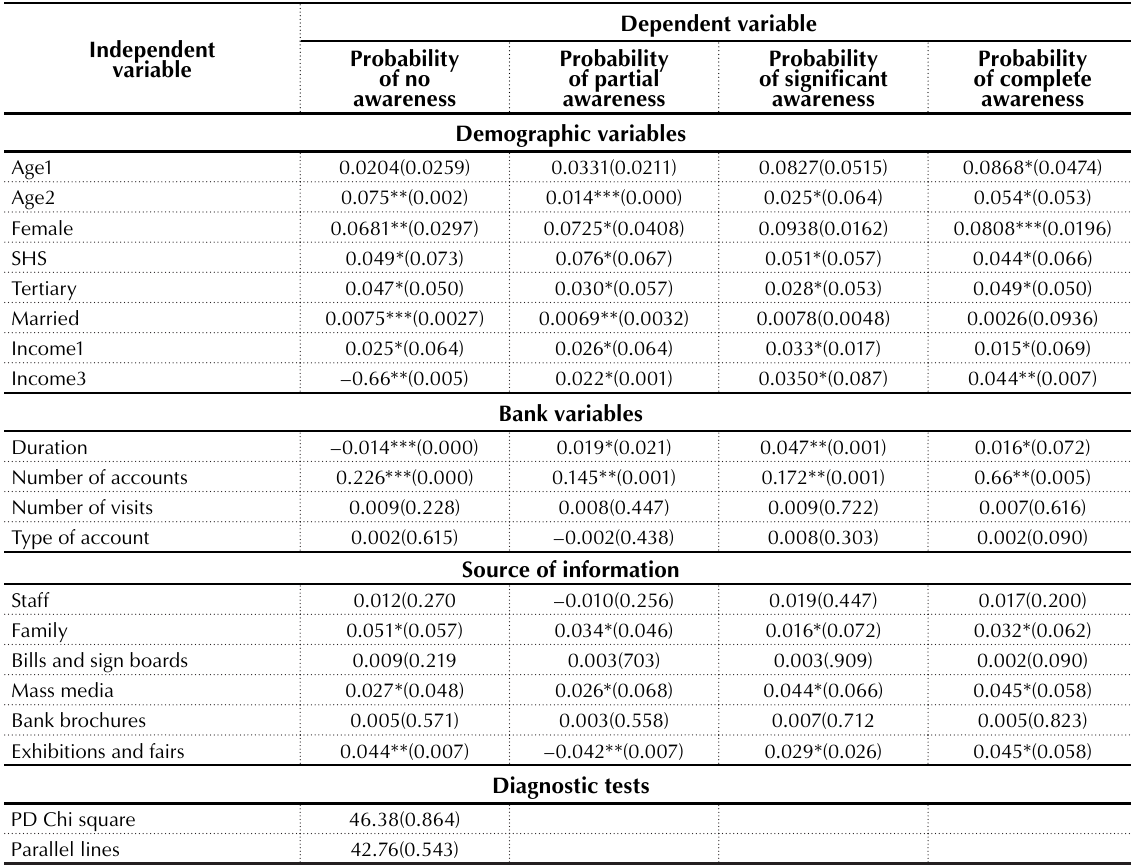
Table 5. Marginal effects of factors affecting the extent of awareness regarding bank products and liaise